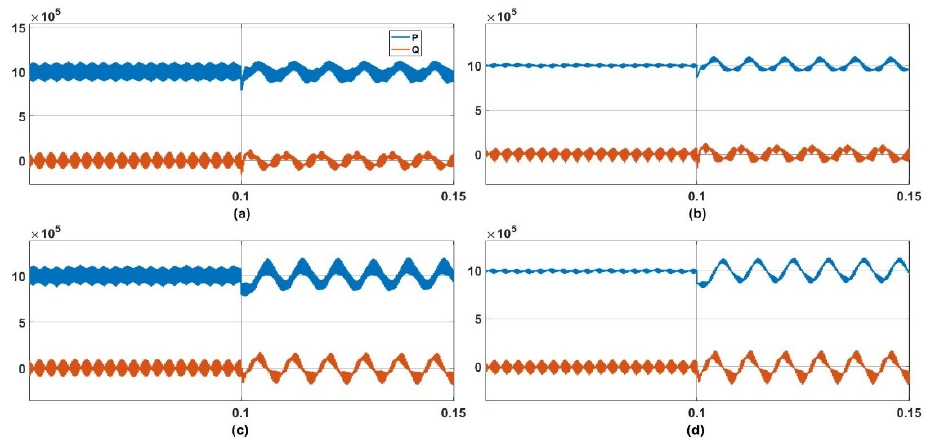
Figure 24. Power flow in an unbalance voltage dip in the case of ( a ) 2L- αβ , ( b ) 3L- αβ , ( c ) 2L-dq and ( d ) 3L-dq . ( d ) 3L-dq.